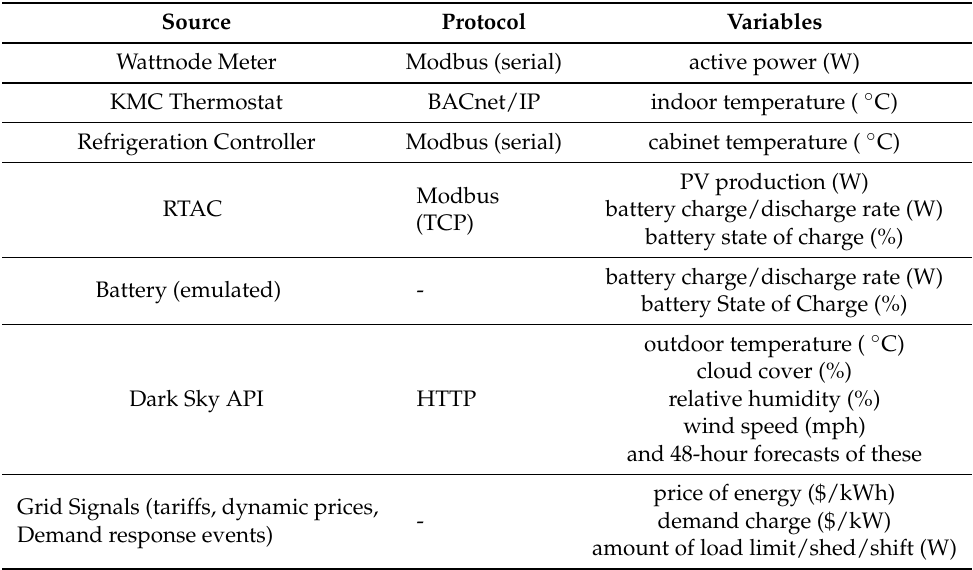
Table 2. List of data sources and relevant variables (Inputs to the optimization engine).